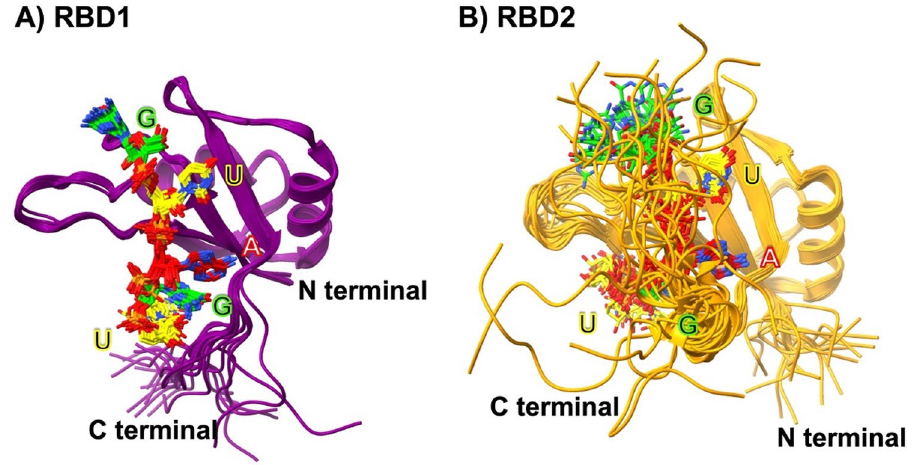
Figure 1. ( A ) Superimposition of the 20 NMR structures of MSI1 RBD1 (PDB ID: 2RS2) and ( B ) MSI1 RBD2 (PDB ID: 5X3Z) with the RNA pentamer GUAGU